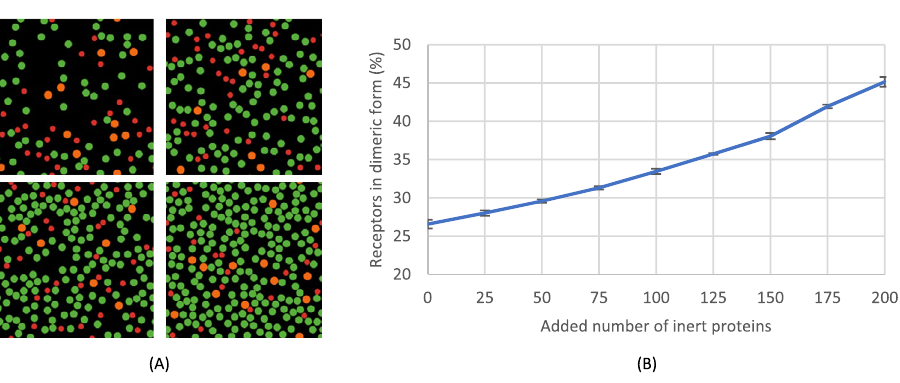
Figure 7. Increasing inert protein crowding induces more receptor dimerisation. Simulation of added inert proteins on the receptor dimerisation. Red and orange dot represents monomeric and dimeric receptors, respectively; green dots represent inert proteins. Simulations were run for ≥ 100,000 steps, with an average of the last 50,000 steps shown. ( A ) Snapshots from the left top with inert proteins of 50, 100, 150 and 200. ( B ) Plot of dimer counts versus number of inert proteins. Note the more abundant dimeric receptors, when protein crowdedness increases. Each simulation was repeated three times, mean ±